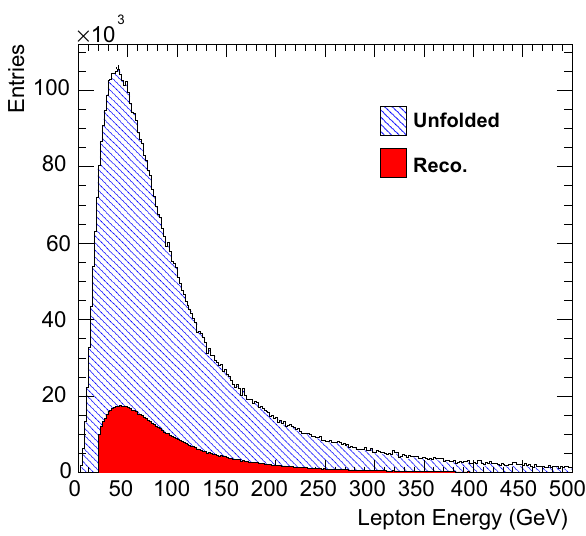
Fig. 2 Unfolded energy distributions of lepton at parton level at the top-quark masses of 167, 173 and 179 GeV After the unfolding procedure, the unfolded energy distri- bution at parton level is used in the weight function